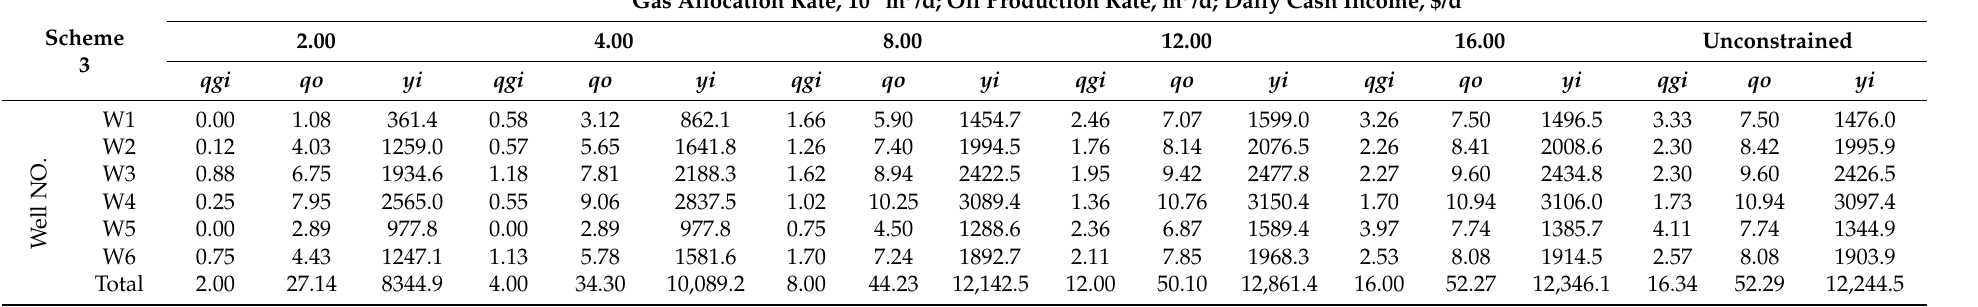
Table 6. Gas allocation result of various total injected gas rate of Scheme 3.